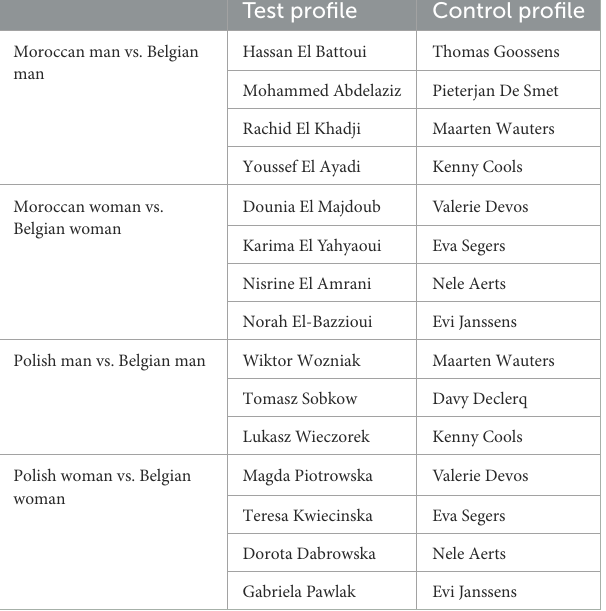
TABLE 1 The names from the online survey that are used in the correspondence